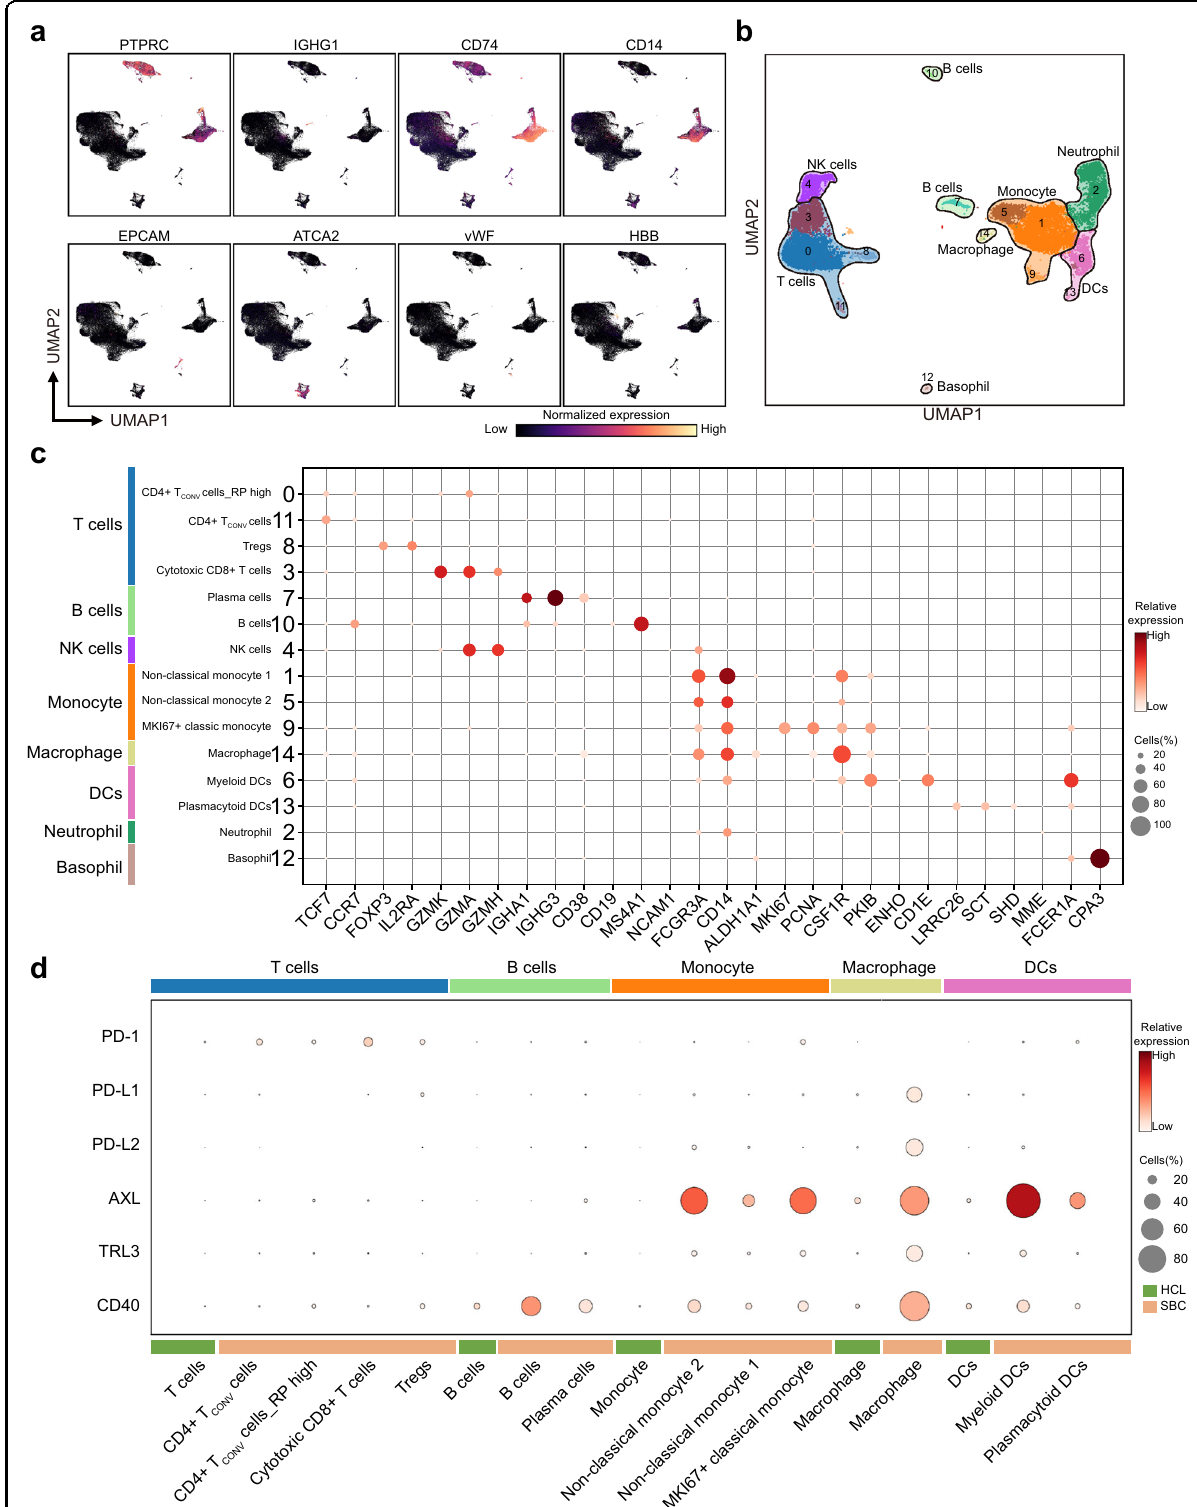
Fig. 2 Expression heterogeneity of nonmalignant cells in the SBC ecosystem. a UMAP plot of each selected canonical marker genes for identifying the clusters. b Fifteen immune cell clusters (marked by numbers) can be partitioned into eight sub-clusters (marked by the text in black) according to the known markers. c Dot plot shows the expression of known marker genes in these eight immune cell sub-clusters. d Comparison of SBC-in fi ltrated and HCL immune cells in PD-1, PD-L1, PD-L2 , and multiple PD-L1